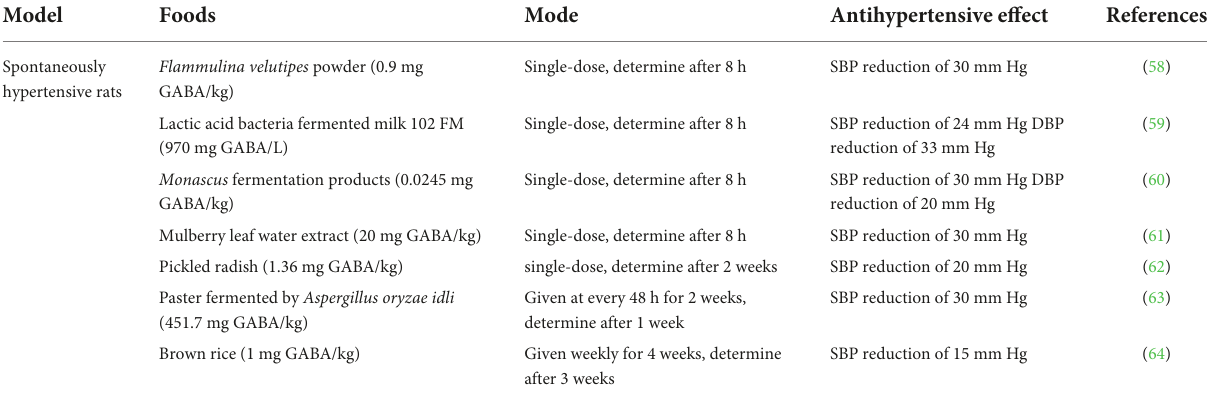
TABLE 2 In vivo antihypertensive effects of GABA-enriched foods.